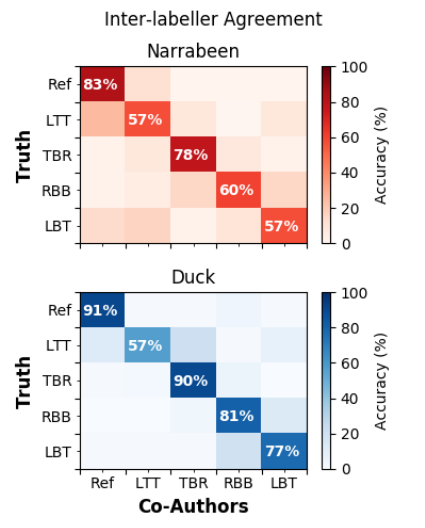
Figure 4. Confusion table plotted as truth vs. other labellers, where “Truth” is defined as the labels chosen by the primary